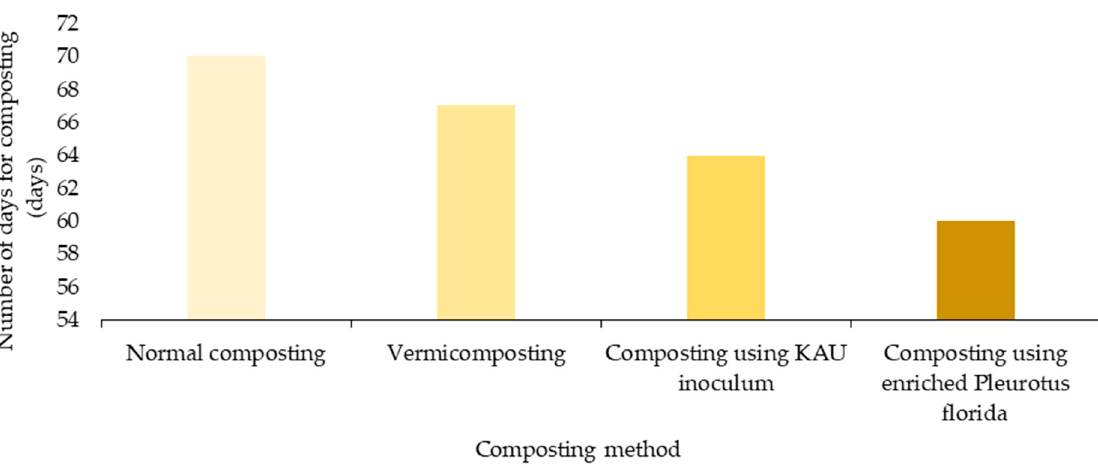
Figure 4. Effect of different composting methods on recovery % [73].